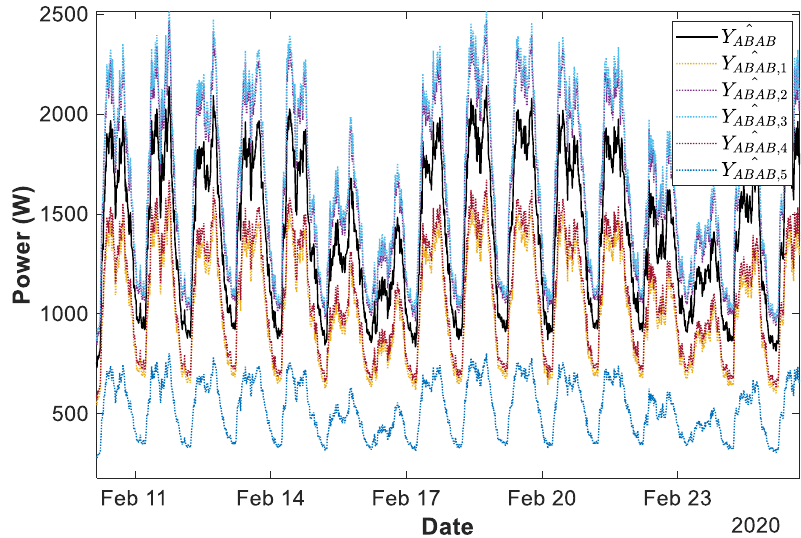
(cid:92) Figure 14. Example of a set of full power profiles (dotted line), 𝑌 𝐴𝐵𝐴𝐵,𝑚 ̂ , synthesized from the esti- Y ABAB , m , synthesized from the Figure 14. Example of a set of full power profiles (dotted line), (cid:92) mate power profile (solid line), 𝑌 𝐴𝐵𝐴𝐵 ̂ , of the cluster ABAB during 11 – 25 February 2020. The num- Y ABAB , of the cluster ABAB during 11–25 February 2020. The estimate power profile (solid line), ber of full power profiles is limited to five for sake of clarity. number of full power profiles is limited to five for sake of clarity.